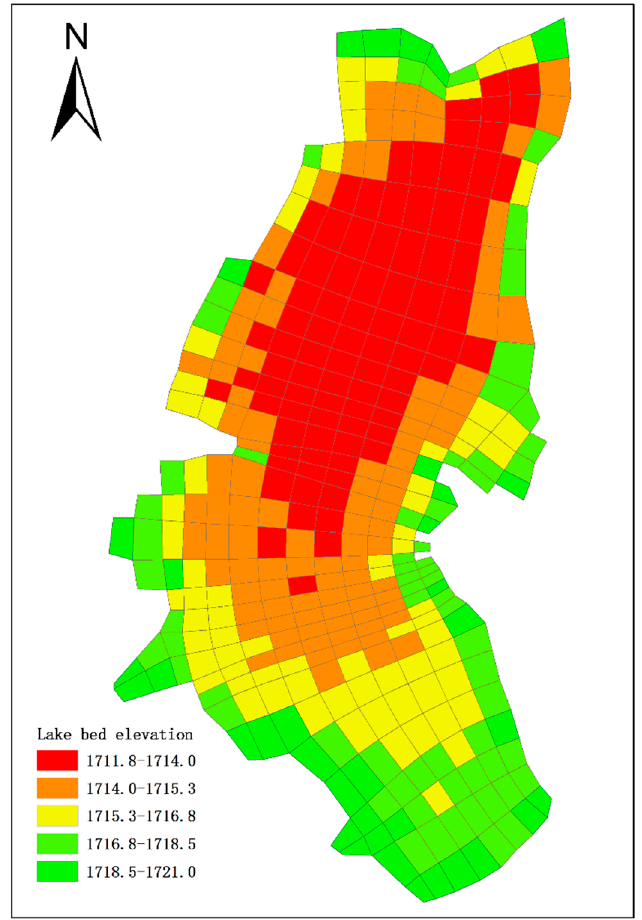
Figure 5. Model grid of Xingyun Lake.